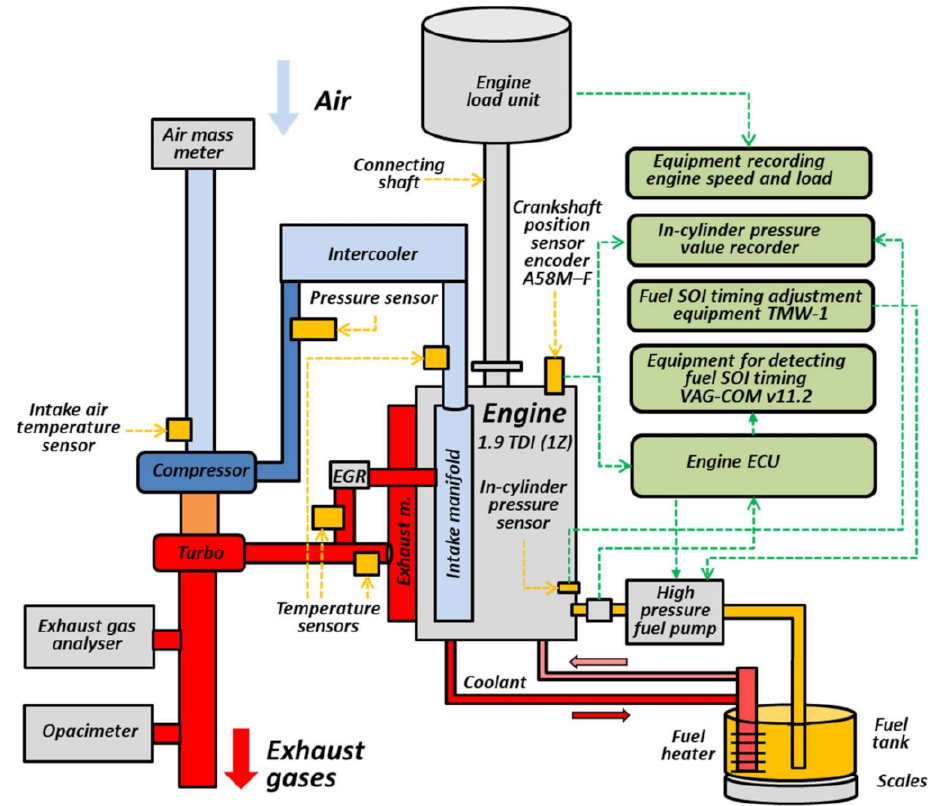
Figure 1. Engine test